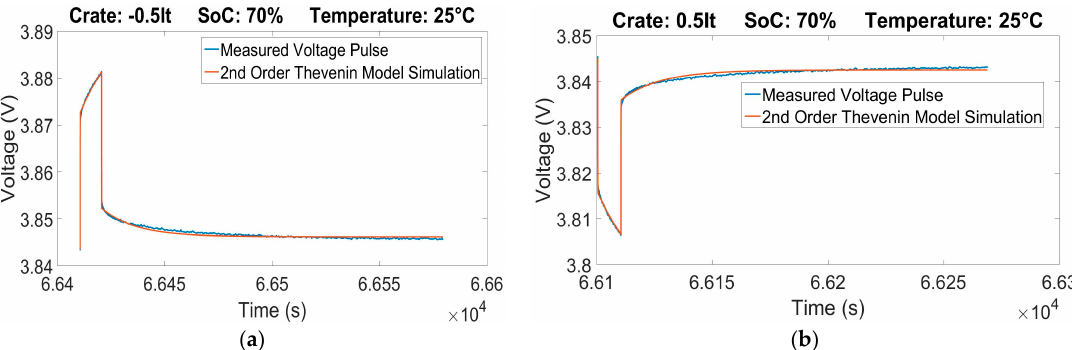
Figure 2. Measured voltage vs. simulated voltage during the 0.5 °C rate pulse at the 70% state of charge (SoC) level of a hybrid pulse power characterization (HPPC) test at 25 °C: ( a ) Charge pulse; and ( b ) discharge pulse.